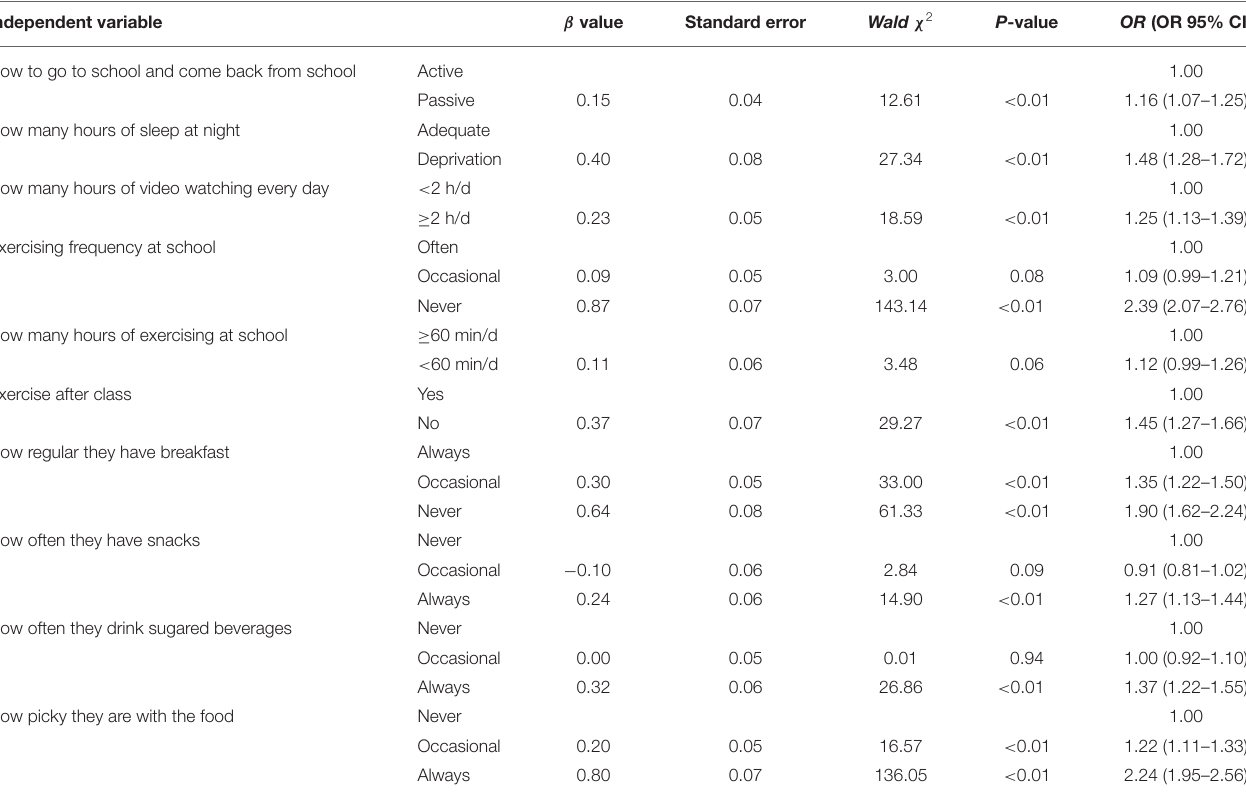
TABLE 2 | Logistic regression analysis on the correlations between lifestyles and psychological symptoms of Chinese middle school students. Independent